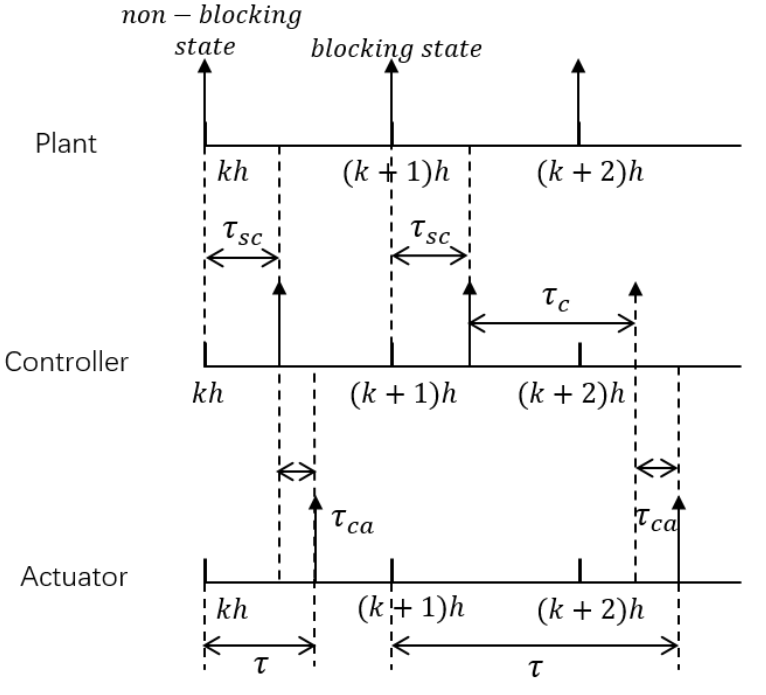
Figure 7. Delay of the CPS